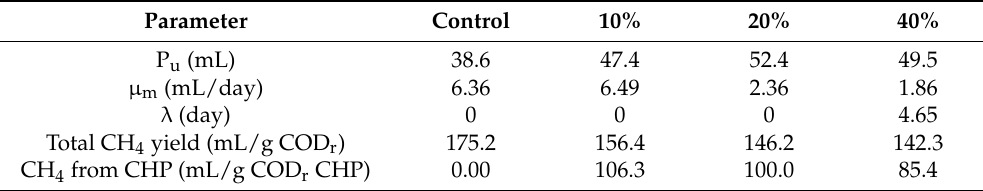
(CHP: coal hydrolysis product, g